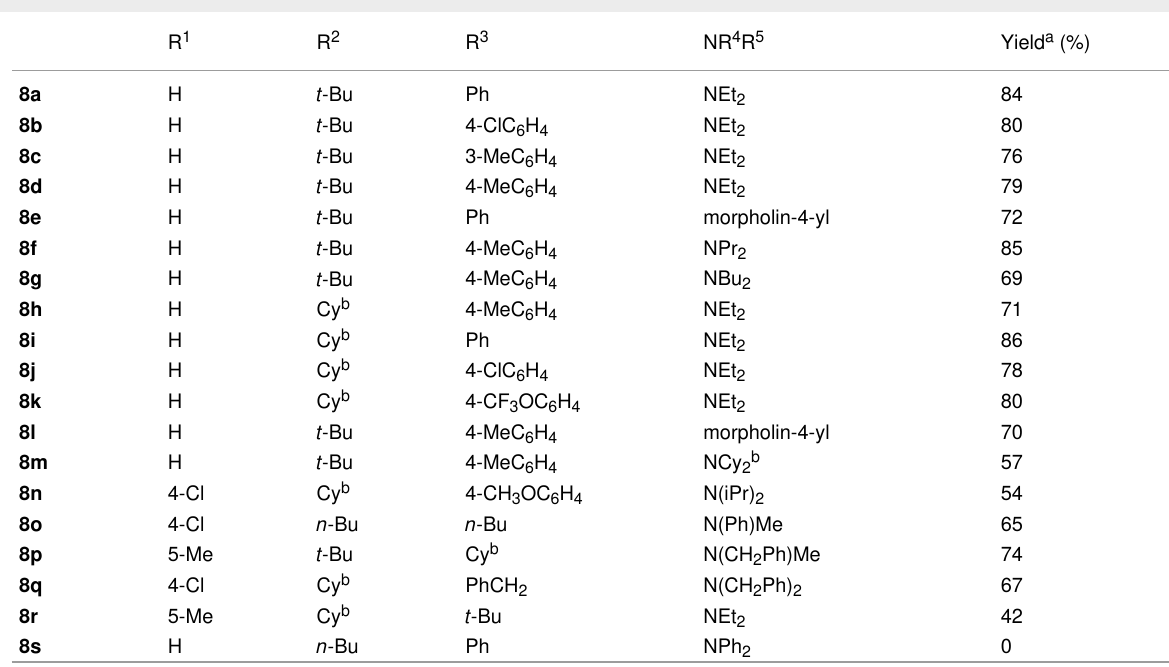
Table 2: Yields of 3,4-dihydroquinazolines 8